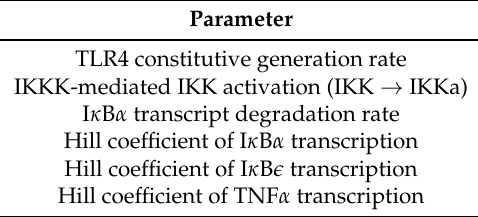
Table 1. The selected parameters when Golgiplug ™ -induced I κ B translation inhibition was not considered.